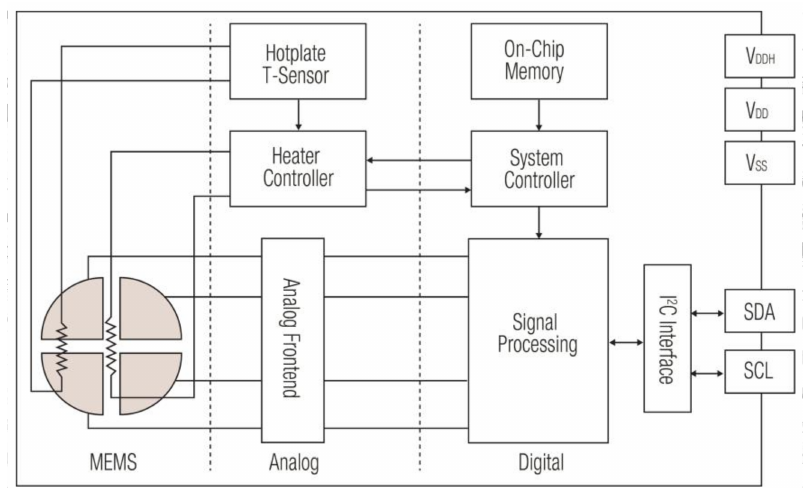
Figure 1. Block diagram of the SGP multi-pixel gas sensor platform [27], including the I 2 C (inter-integrated circuit) bus interface, consisting of serial data (SDA), serial clock (SCL), supply and ground voltages V DD and V SS . V DD and the hotplate supply voltage V DDH can be